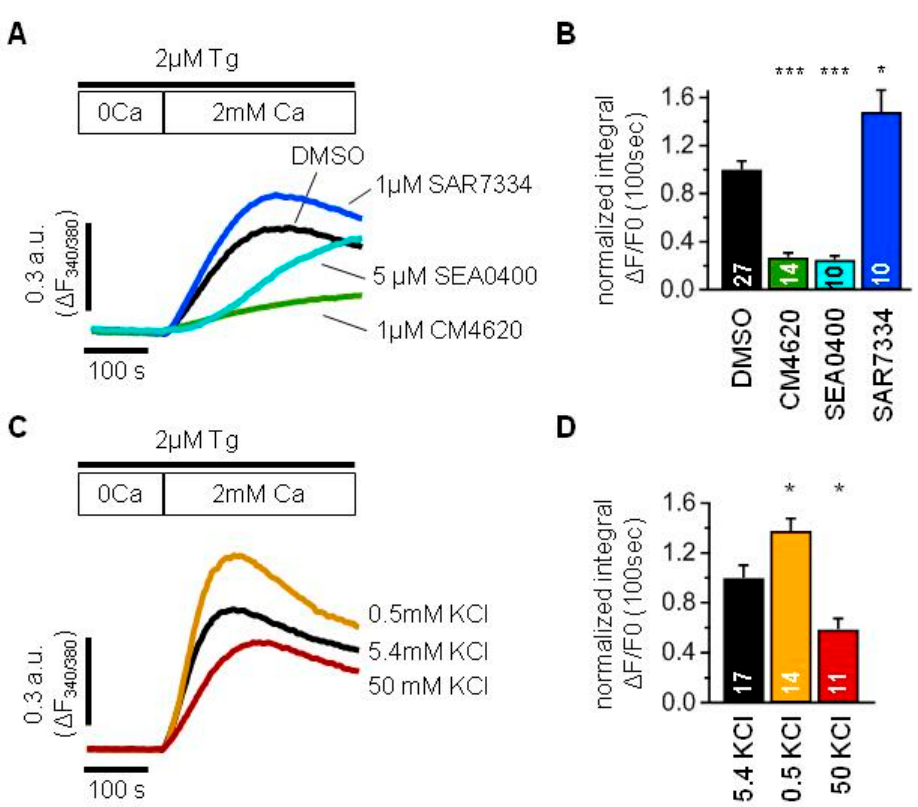
Figure 2. TRPC6 channels modulate store-operated Ca 2+ entry mediated by ORAI and NCX in human culture podocytes Ab8/13. ( A , C ) An averaged traces demonstrating ratio of fura-2 fluorescence at 340 and 380 nm, which reflect changes in intracellular Ca 2+ concentration in human podocytes Ab8/13. Cells were incubated with 2 µ M Tg in 0 mM Ca 2+ solution for 10 min and afterwards 2 mM Ca 2+ solution was added to register store-operated Ca 2+ entry. ( B , D ) Bar plots showing the normalized fura-2 fluorescence ratio integrated over 100 s right after addition of 2 mM Ca 2+ . ( A , B ) Shown are control Ca 2+ response (black), Ca 2+ response in the presence of 1 µM CM4620 (green), Ca 2+ response in the presence of 1 µM SAR7334 (blue) and Ca 2+ response in the presence of 5 µ M SEA0400 (light blue). ( C , D ) Ca 2+ entry recorded in the presence of 5.4 mM KCl used as control (black), 0.5 mM KCl (gold), 50 mM KCl (dark red). Data were statistically analyzed by Kruskal–Wallis test followed by Dunnett’s test. *, and *** indicate p values of <0.05, and <0.001, respectively.